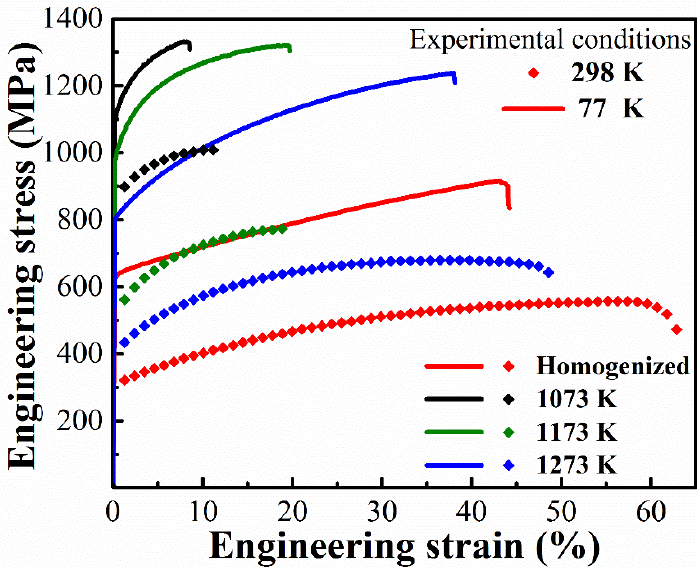
Figure 4. The cryogenic temperature tensile engineering stress–strain curves with different heat treatment conditions at 77 K.